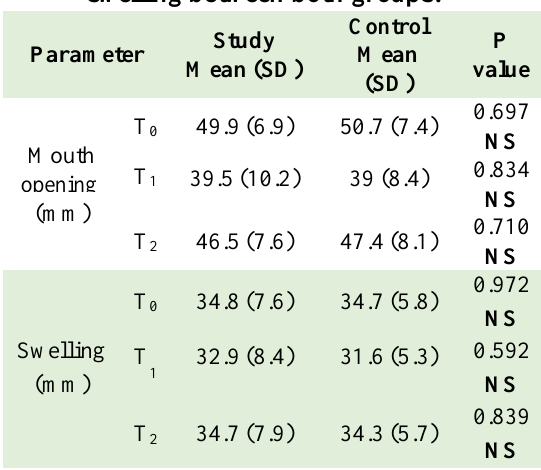
Table 3: The mouth opening and swelling between both groups.